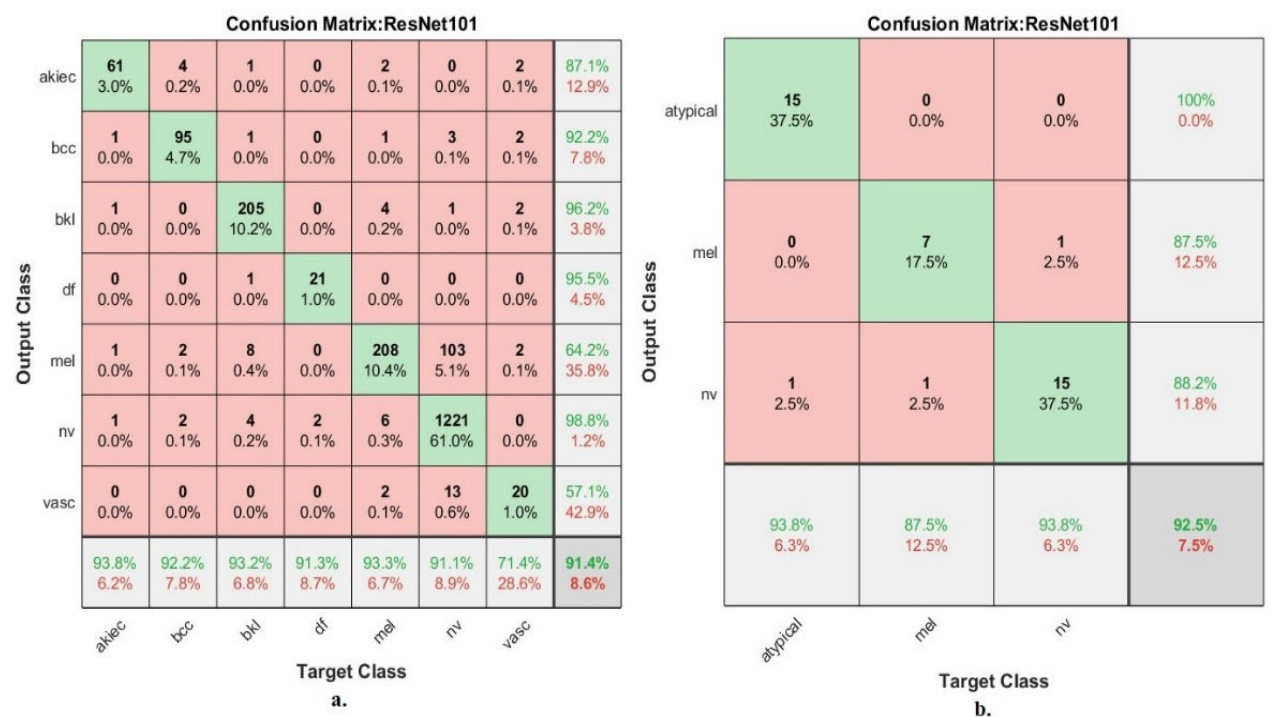
Figure 9. Confusion matrix for the classification of two skin lesion datasets by MobileNet through datasets of ( a ) HAM10000 and ( b ) PH2.